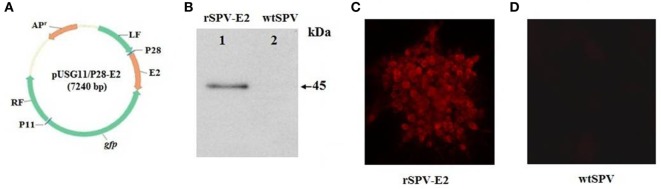
Construction and identification of the recombinant virus. (A) Construction of the pUSG11/P28-E2 transfer vector. LF and RF indicate the swinepox virus (SPV) left flanking sequences and SPV right flanking sequences, respectively. P11 and P28 are the vaccinia virus promoters. The GFP reporter gene is also included in the plasmid. (B) Western blot analysis of E2 expression in PK15 cells: lane 1: PK15 cells infected by rSPV-E2; lane 2: PK15 cells infected by wtSPV. (C,D) Indirect immunofluorescence assay of the rSPV-E2. (C) Red fluorescence could be observed in rSPV-E2-infected PK15 cells, in which the fluorescence was localized to the cytoplasm. (D) No fluorescence was observed in PK15 cells infected with wtSPV.